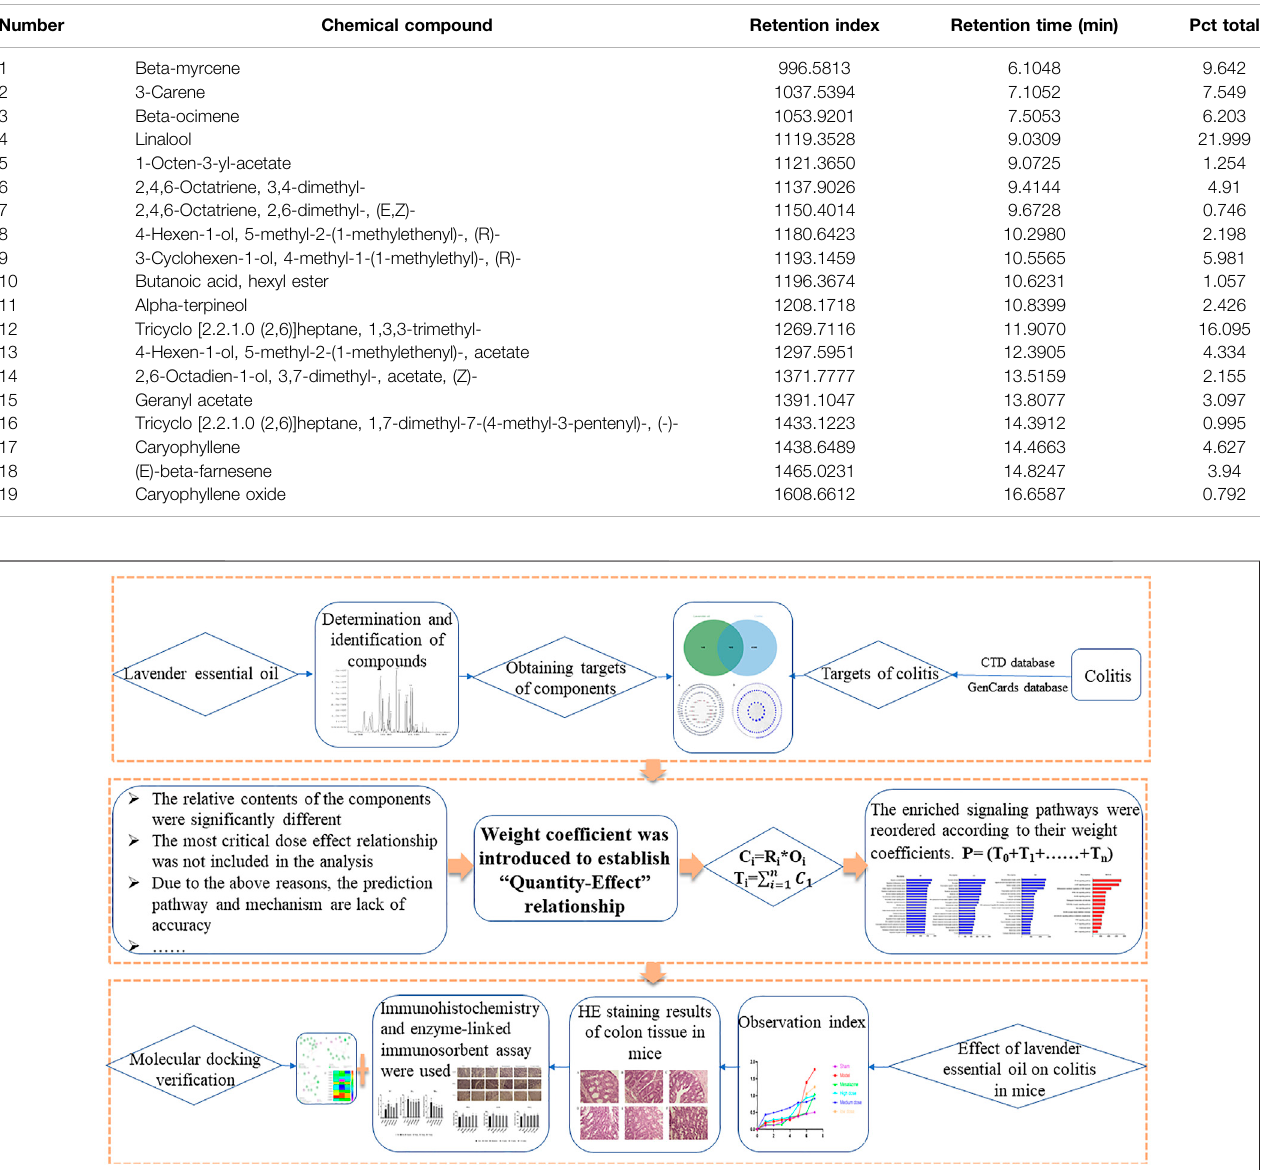
TABLE 2 | Chemical composition of lavender essential